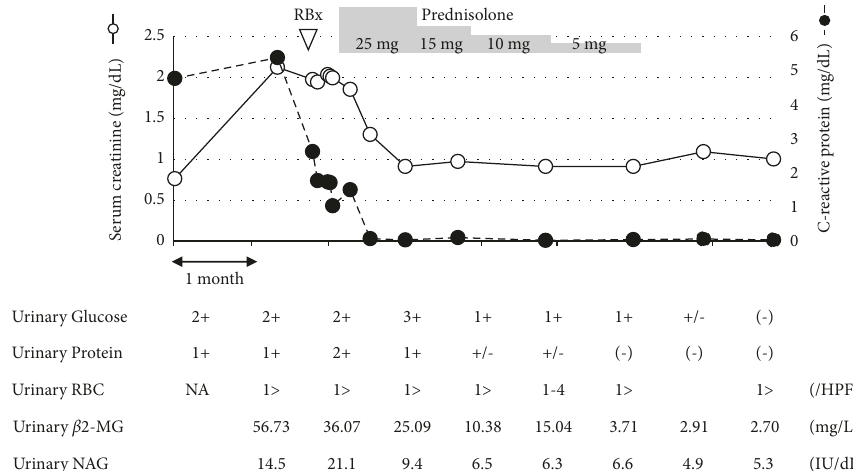
Figure 1: Clinical features and course of case 1. Renal biopsy of case 1 was performed approximately 2 months after disease onset. Disease activity and effectiveness of treatment for acute tubulointerstitial nephritis were monitored by renal function (serum creatinine), in- flammation (C-reactive protein), and tubular functional defects (urinary glucose, protein, β 2-microglobulin, and N-acetylglucosaminidase).